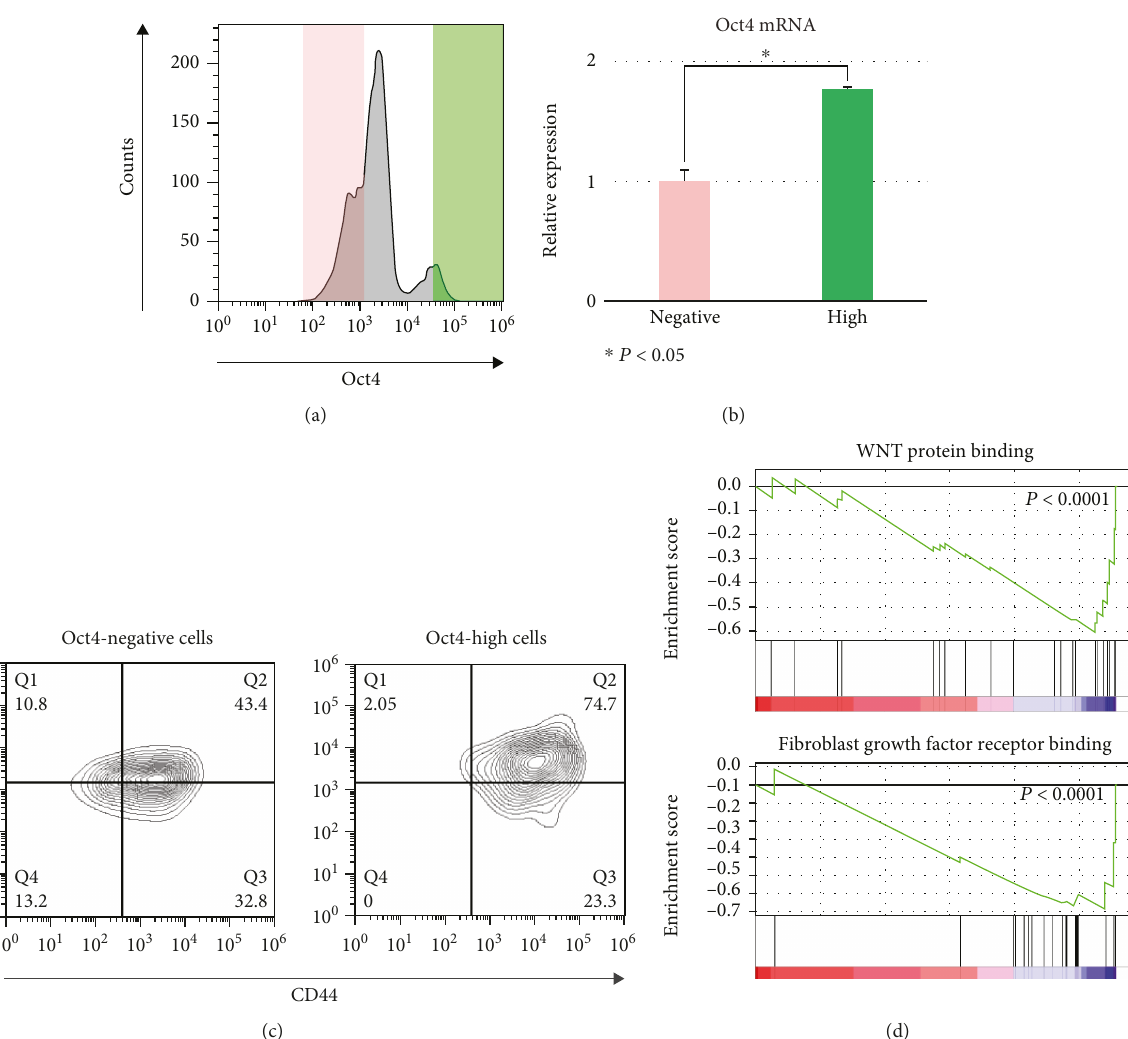
Figure 2: Analysis of Oct4-EGFP-positive cells. (a) Representative FACS of enriched Oct4-EGFP cells by sorting. Oct4-positive cells and Oct4-negative cells were shown. Oct4-high cells (green area) and Oct4-negative cells (pink area) were analyzed. (b) Oct4 mRNA expression of Oct4-high cells (green area of (a)) was high compared with that of Oct4-negative cells (pink area of (a); n = 3 , P < 0 05 ). (c) Expressions of CD44 and CD133 were high in Oct4-high cells (green area of (a)) compared with Oct4-negative cells (pink area of (a)). (d) Gene set enrichment analysis (GSEA) of Oct4-high cells (green area of (a)) and Oct4-negative cells (pink area of (a)). Representative GSEA was shown, and genes relating to WNT protein binding ( P < 0 001 ) and fi broblast growth factor receptor binding ( P < 0 001 ) were enriched in Oct4-high